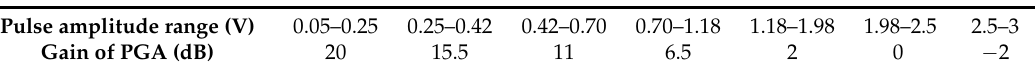
Table 1. Grading of the PGA gain. The PGA gain is adjusted to concentrate the input pulse amplitude